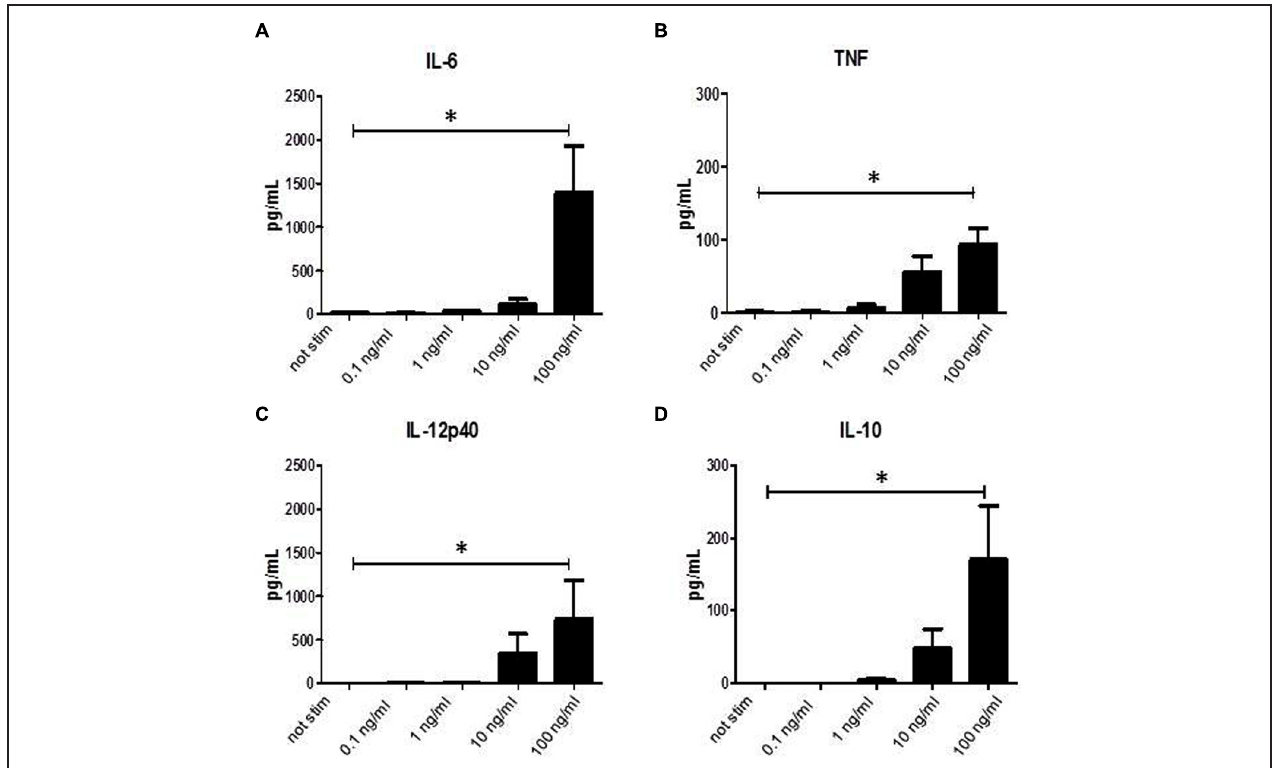
FIGURE 1 | Streptococcal pyrogenic exotoxin A (SPEA)- induced cytokines. CD14 + monocytes were stimulated with increasing concentrations of SPEA. 24 h after stimulation supernatants were analyzed by ELISA for (A) IL-6, (B) TNF, (C) IL-12p40 and (D) IL-10 (mean ± SD, n = 5). Statistical analysis was performed using a Multiple Comparison of Means (Tukey Contrasts). Significance code: 0 ‘ ∗∗∗ ’; 0.001 ‘ ∗∗ ’; 0.01 ‘ ∗ ’.